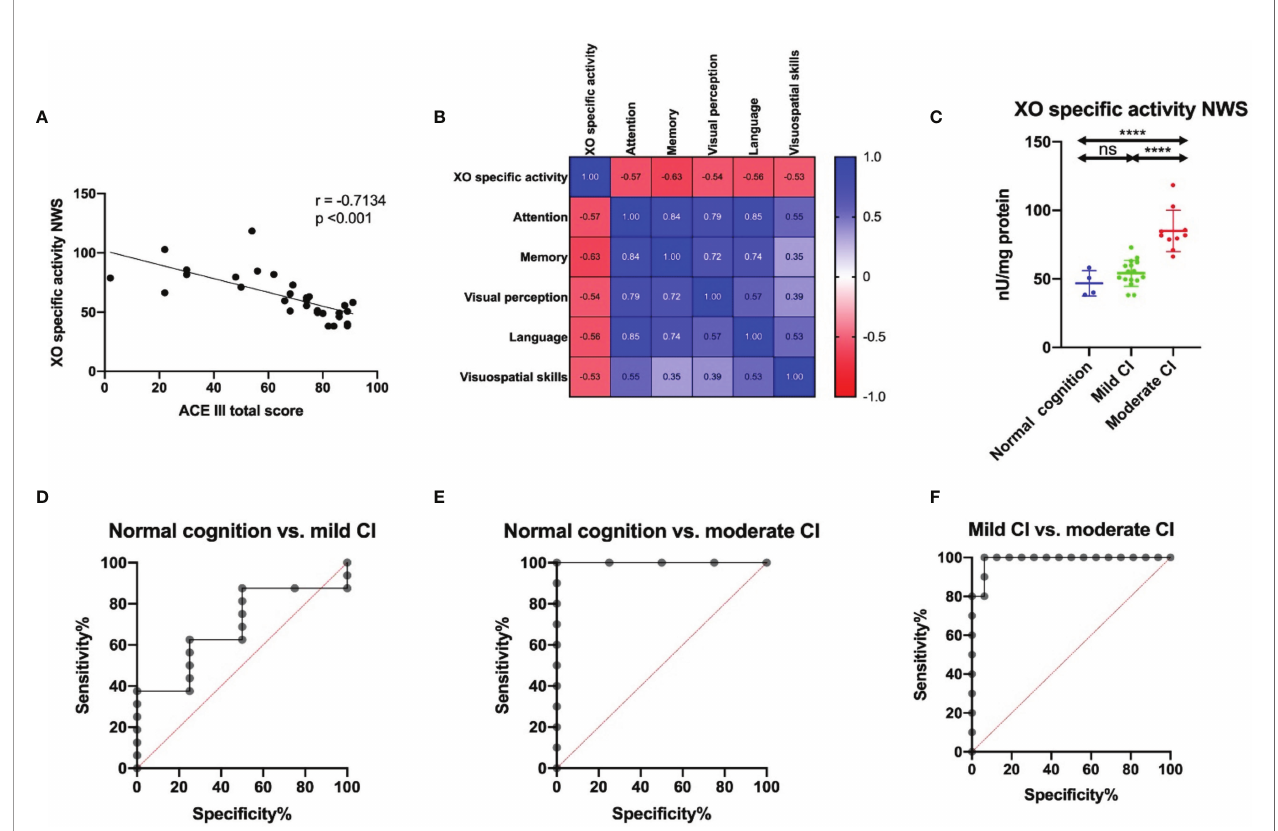
FIGURE 4 | Correlation between salivary XO speci fi c activity and cognitive function in ACE III scale (A) , correlations between XO speci fi c activity and several parameters of ACE III score (B) ; results of ROC analysis for salivary XO speci fi c activity in relation to cognitive function status in ACE III scale in NWS (C – F) . ACE III, Addenbrooke ’ s Cognitive Examination III; mild CI, mild cognitive impairment; moderate CI, moderate cognitive impairment; NWS, non-stimulated whole saliva; XO, xanthine oxidase. Differences statistically signi fi cant at ****p < 0.0001. ns, non signi fi cance.